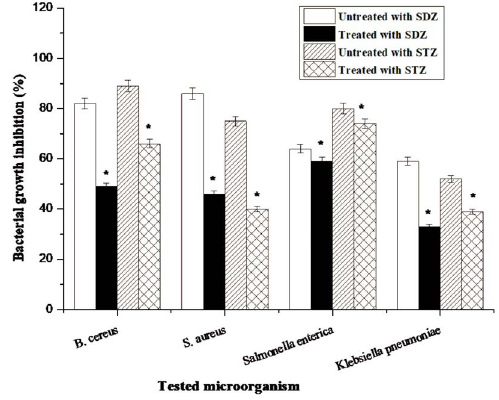
Fig. 4. Growth inhibition percentage of untreated and laccase-treated sulfa drugs (sulfadiazine (SDZ), sulfathiazole (STZ)) against tested bacterial strains. Where, Untreated: sulfa drug solution without SSF laccase; Treated: sulfa drug solution treated with SSF laccase. The columns followed by asterisks are significantly different according to paired-samples t test. Values are the mean of three replicates. The bars represent the standard error of the